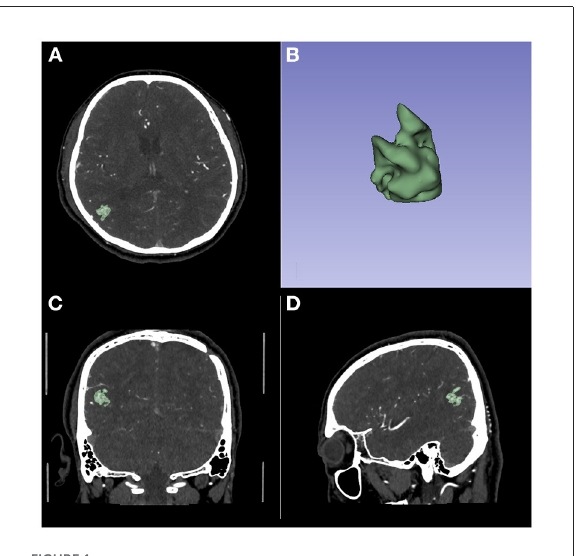
FIGURE1 An example of 3D model building on CT Angiography image. (A) The axial image. (B) The 3D model. (C) The coronal image. (D) The sagittal